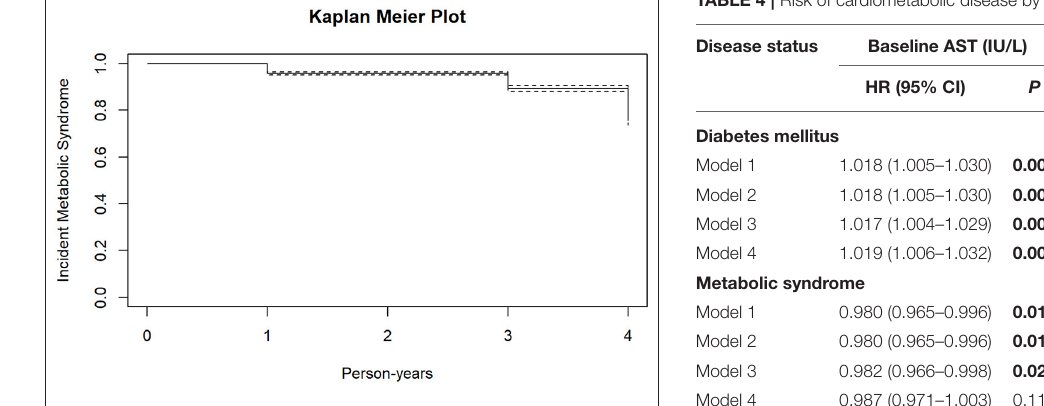
FIGURE 3 | Kaplan meier plot for incident metabolic syndrome.